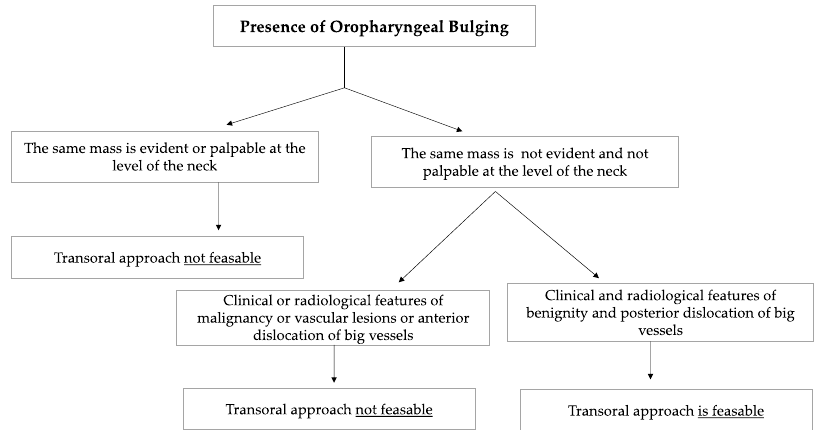
Figure 8. The flow chart shows the criteria considered when deciding whether or not to opt for a